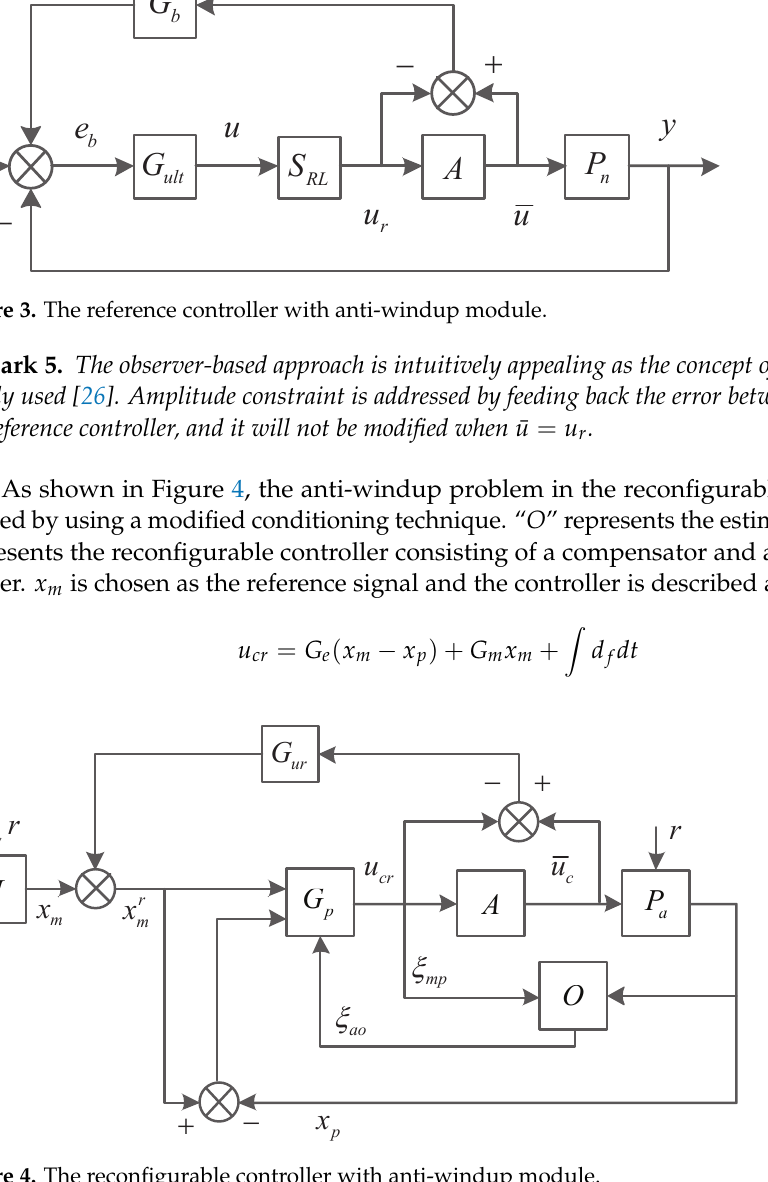
Figure 4. The reconfigurable controller with anti-windup